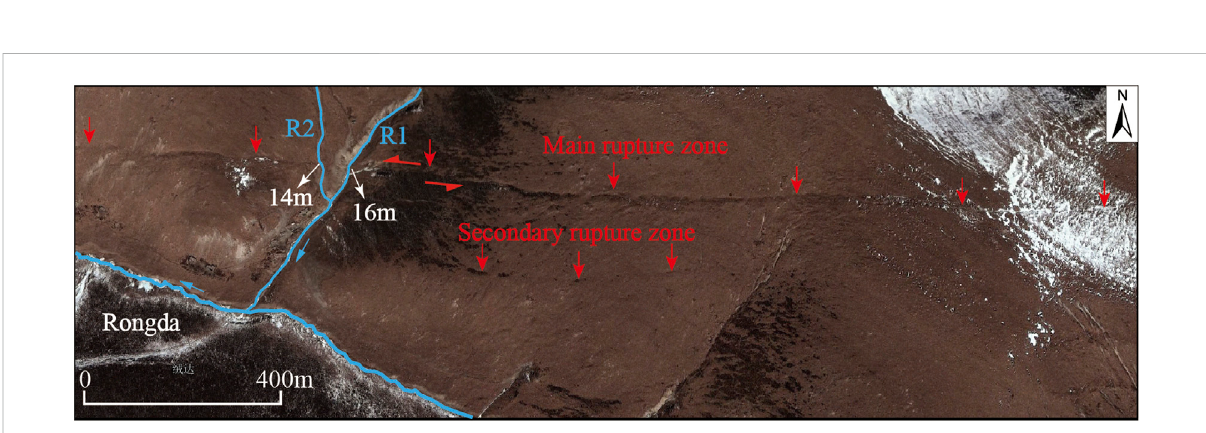
FIGURE 3 SurfaceruptureontheMaisufaultnearRongda,westofPuma.TheimagewasobtainedfromGoogleEarth(referencecoordinates:E98.85883 ° , N31.66850 °